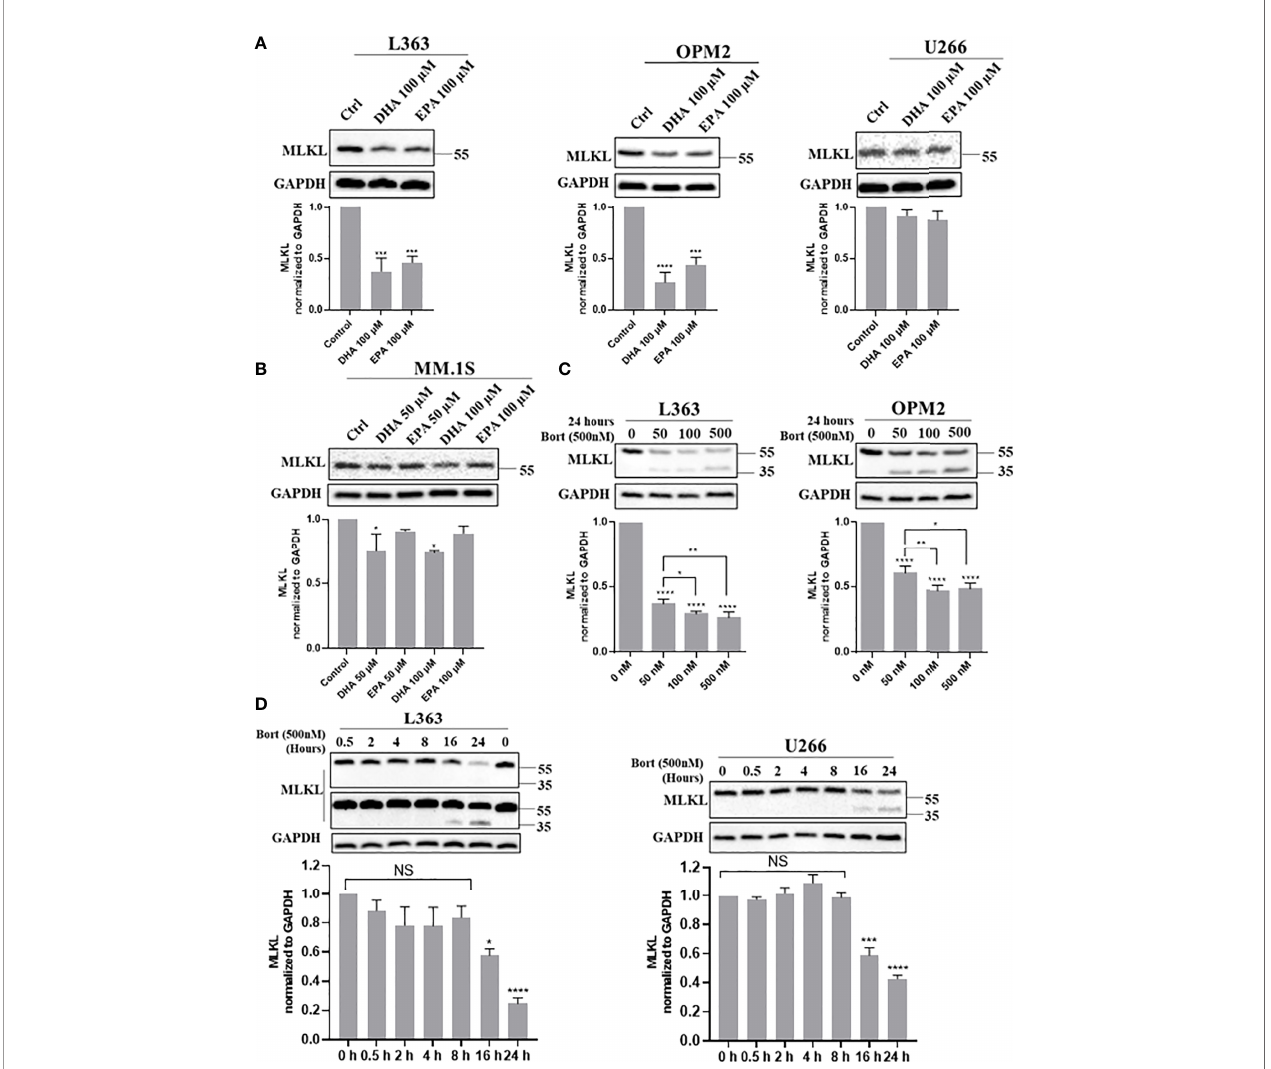
FIGURE 2 | Cell death triggers down-regulate total MLKL and bortezomib induces a 35 kDa protein in MM cells. (A, B) L363, OPM2, U266 and MM.1S cells were treated with indicated concentrations of DHA/EPA for 24 h. (C) OPM2 and L363 cells were treated with indicated concentrations of bortezomib for 24 h. (D) L363 and U266 cells were treated with bortezomib (500 nM) for 0, 0.5, 2, 4, 8, 16 and 24 h. After treatments, cells were lysed with RIPA buffer and cell lysates were subjected to western blotting with antibodies against C-terminus and GAPDH. Data were expressed as mean ± SD of three independent experiments. * p < 0.05, * * p < 0.01, *** p < 0.001, **** p < 0.0001 when compared with control, NS, no signi fi